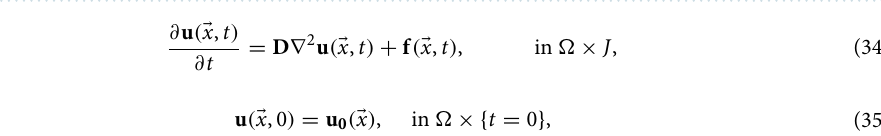
3 -3-6) with Dirichlet boundary values ( g =